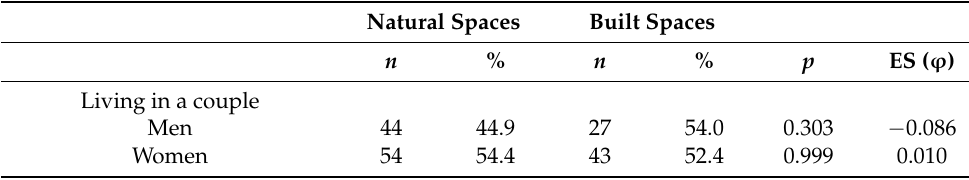
Table 1. Sample characteristics according to running